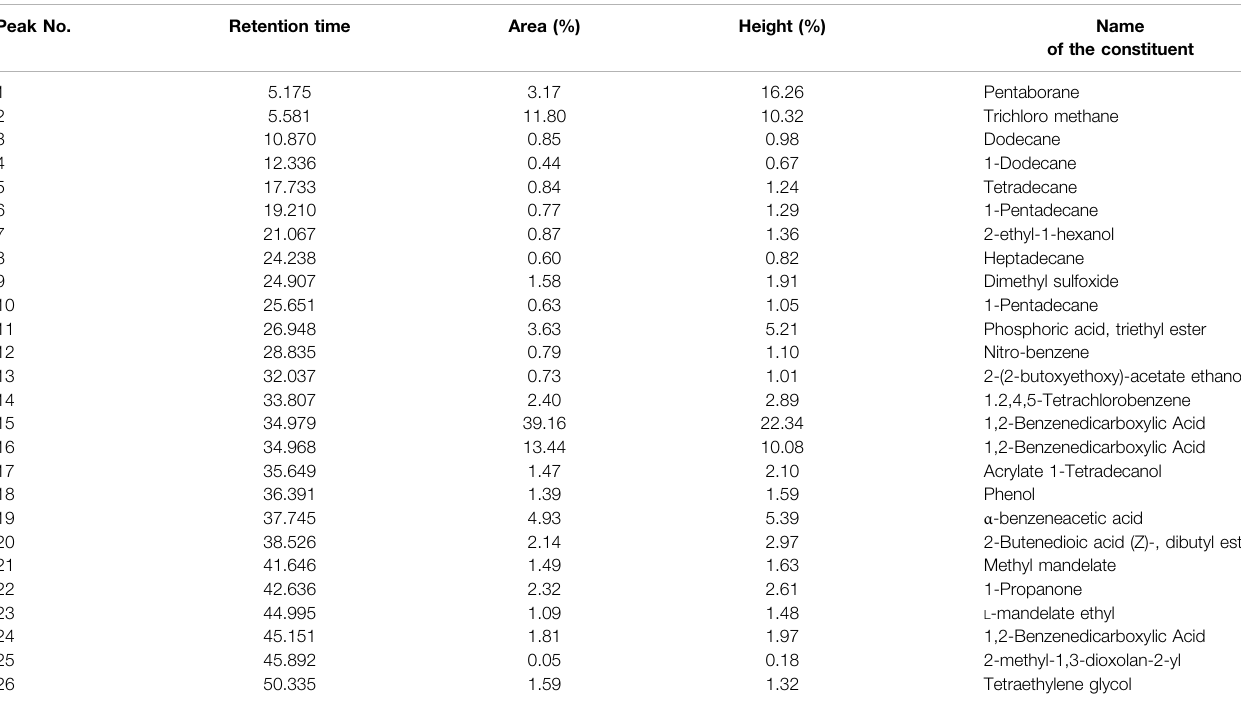
TABLE 2 | List of different phytochemicals present within the ethanolic leaf extracts of Adenium obesum as recognized through GC-MS analysis. Peak No. Retention time Area (%) Height (%) Name